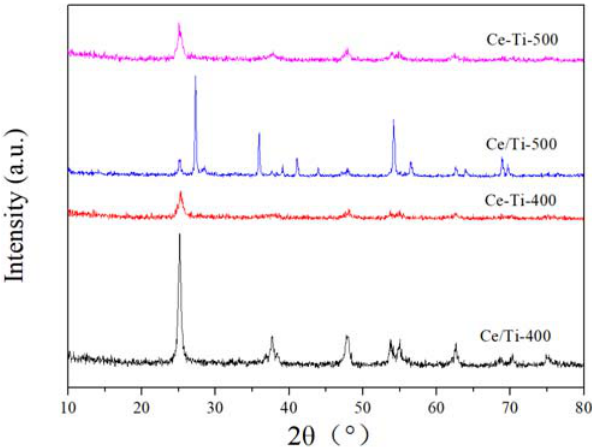
Figure 2. X-ray diffraction (XRD) patterns of catalysts prepared by different methods.